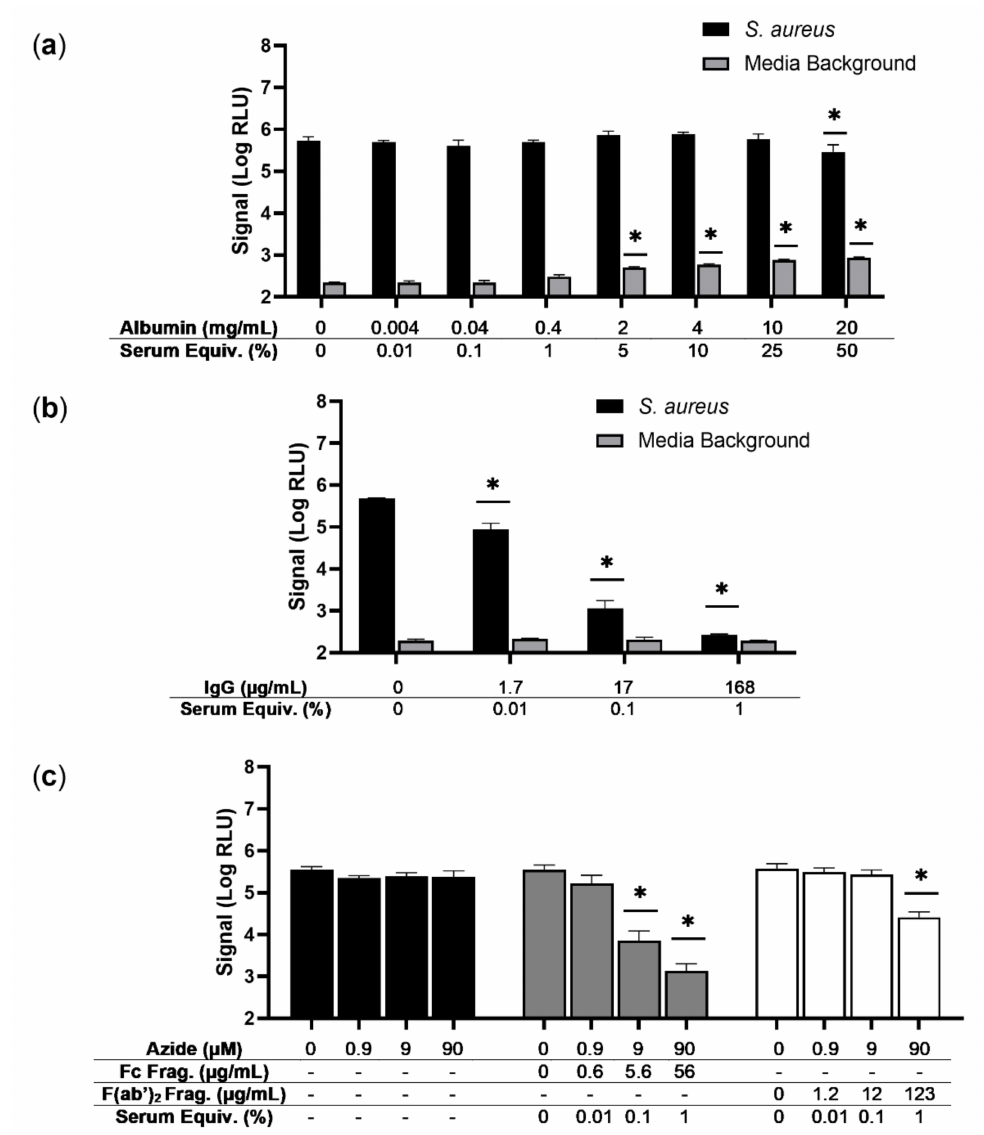
Figure 3. Analysis of serum proteins for inhibition of phage-based detection. Human serum al- bumin ( a ), human immunoglobulin G (IgG) ( b ), or fragments of human IgG ( c ) were diluted in TSB spiked with approximately 100 CFU of S. aureus (ATCC 12600). In ( a , b ), media background is the indicated reagent diluted in TSB alone. Luciferase production was evaluated following a 4 h enrichment and a 2 h infection and is provided as log-transformed relative light units (Log RLU). Error bars represent standard deviation from triplicate wells. A two-way ANOVA with a Bonferroni’s multiple comparisons test was performed, comparing the concentration of each serum protein to the corresponding media or buffer control. Asterisks (*) indicate significance ( p < 0.05). To allow comparison, the approximate percentage of serum that each protein concentration is equivalent to is provided (Serum